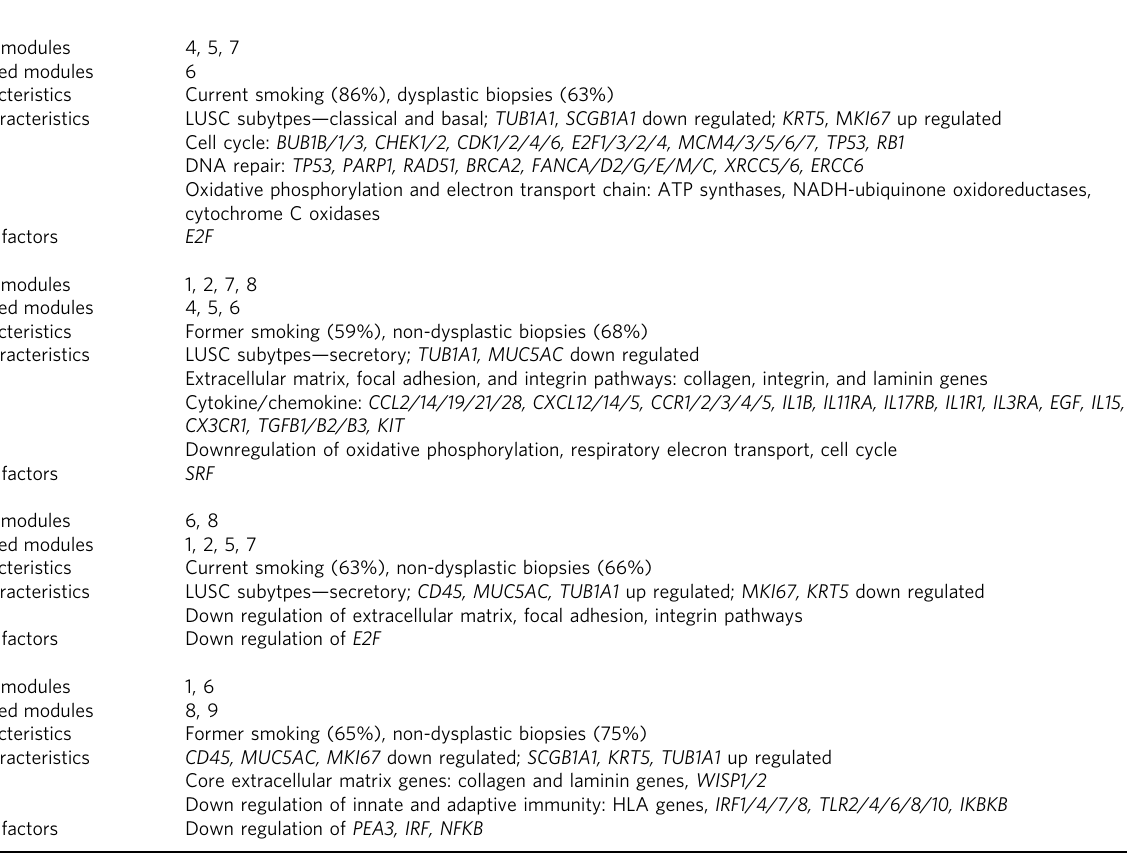
Table 3 Molecular subtype characteristics in the discovery cohort Proliferative Up-regulated modules 4, 5, 7 Down-regulated modules 6 Clinical